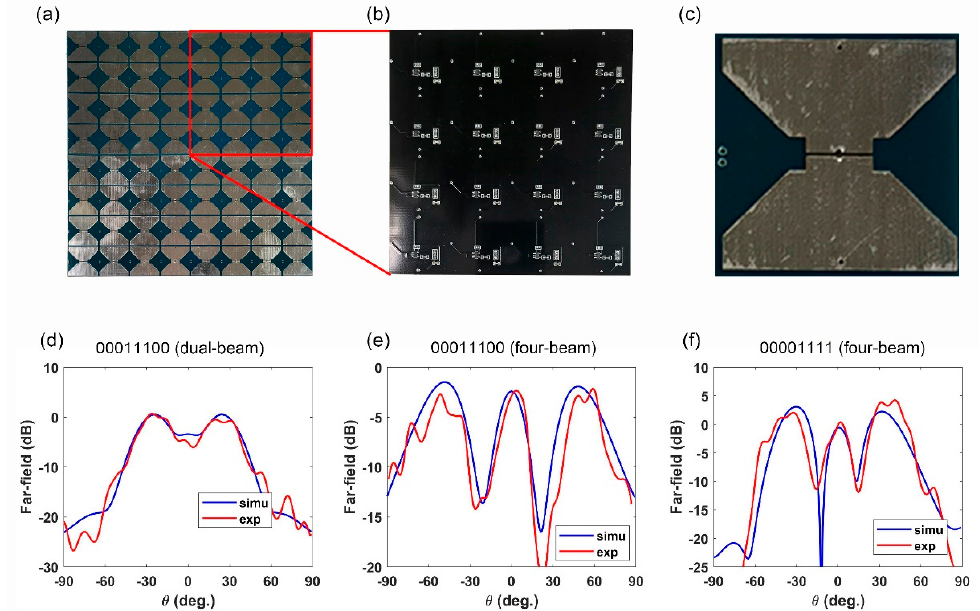
Figure 6. The details of the metasurface sample and the far-filed results. ( a ) A photograph of the sample shows the details of the fabricated metasurface sample, and the components distributed on it; ( b ) the soldering and circuit distribution of the microcircuit; ( c ) the top view of the sample meta-cell; ( d – f ) comparison of the simulated and measured far-field results of the metasurfaces for the three coding patterns.